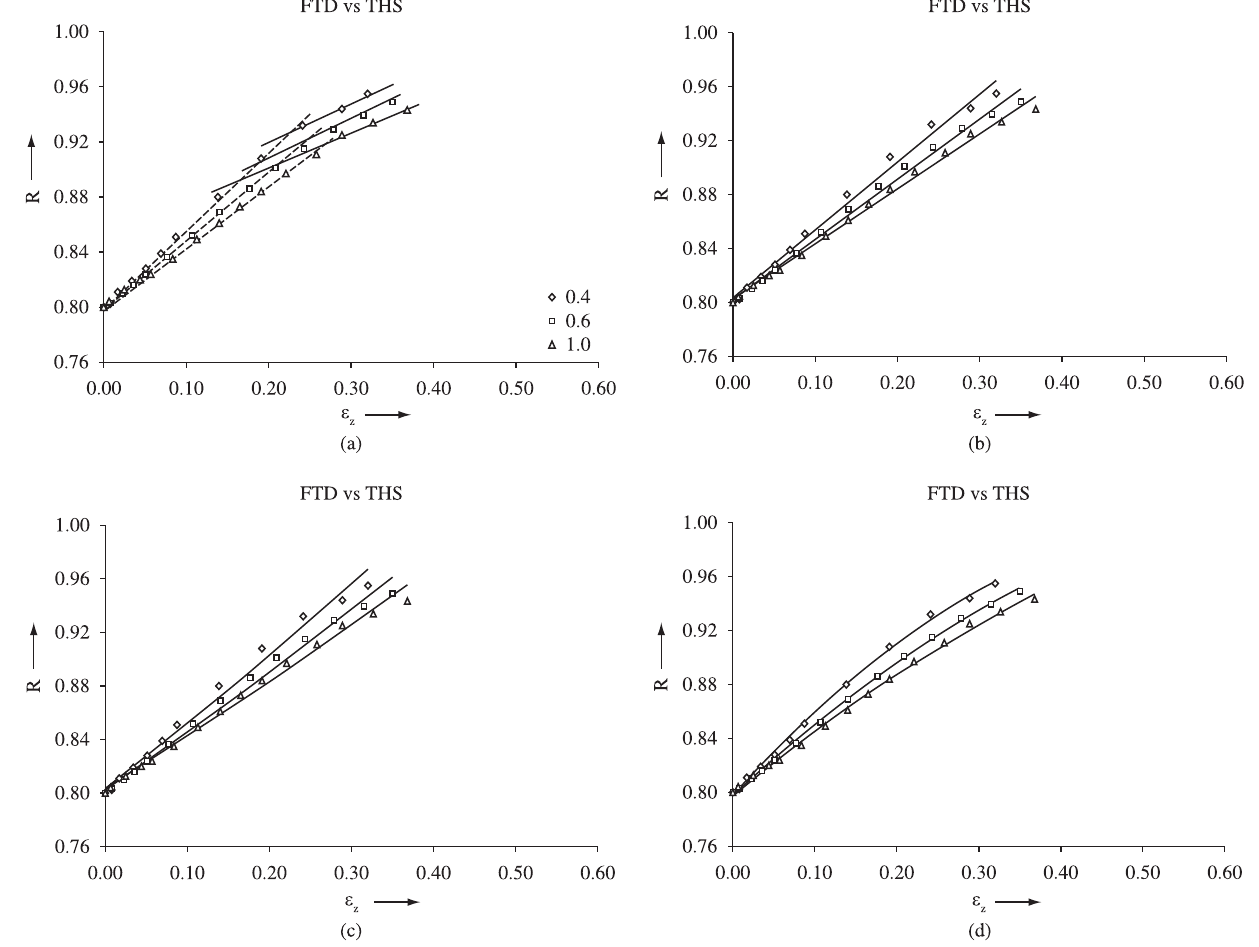
; b) relationship between R and e z – parabolic curve fitting. z z